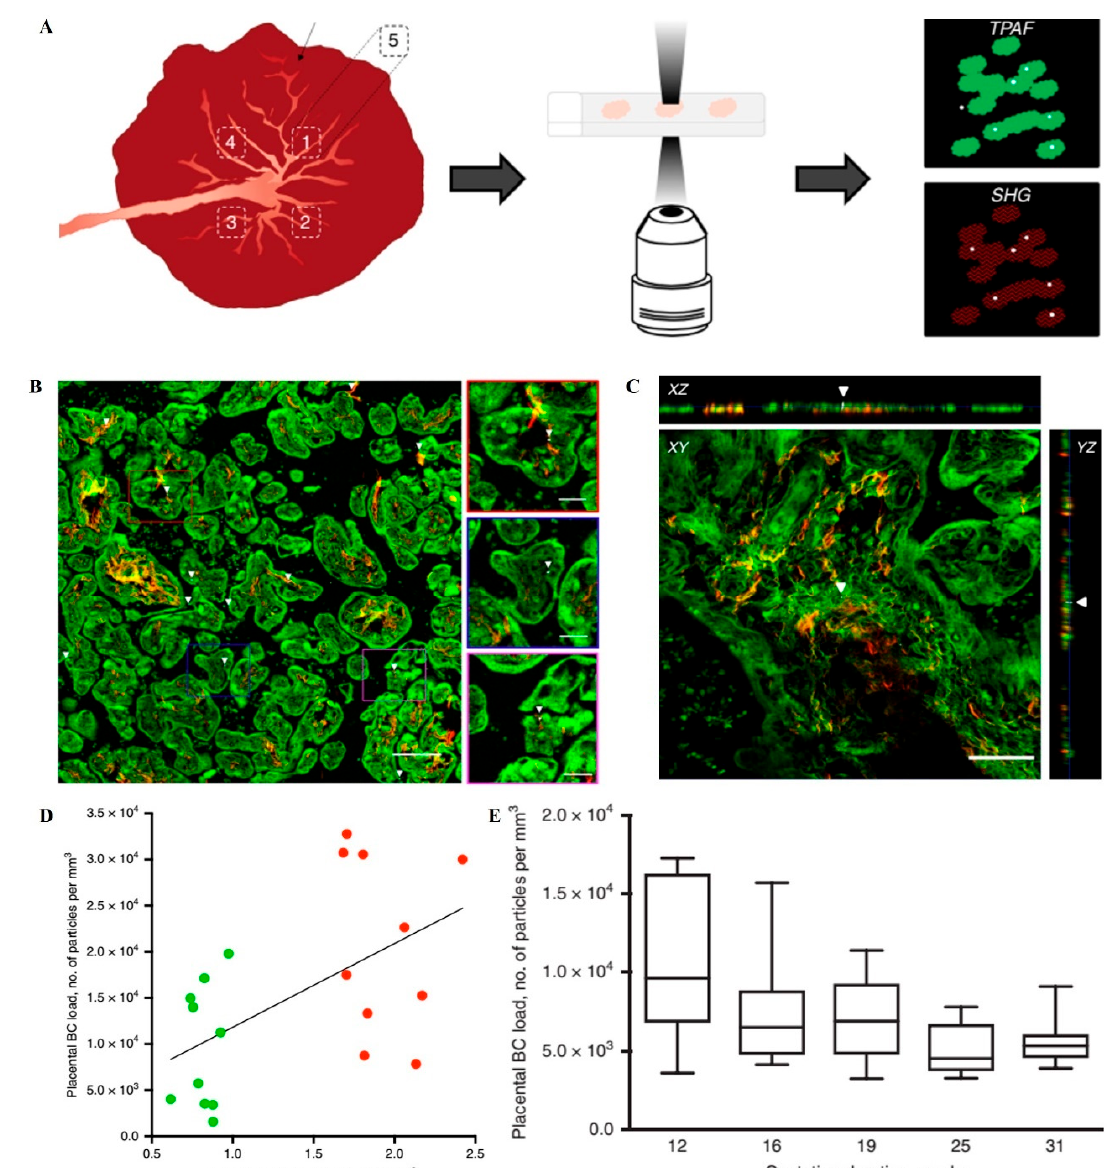
Figure 1. The protocol for black carbon detection in the placenta and evidence of them at the fetal side of human placenta. ( A ) The detection of BC particles in placenta. The white light produced by the BC naturally present in the tissue (white dots) is detected along with the simultaneous generation and detection of two-photon excited autofluorescence (TPAF) of the cells (green) and second harmonic generation (SHG) from collagen (red). ( B ) The evidence of ambient BC particles at the fetal side of human placenta. White light (WL) generation originating from the BC particles (white and further indicated using white arrowheads) under femtosecond pulsed laser illumination (excitation 810 nm, 80 MHz, 10 mW laser power on the sample) is observed. Scale bar: 30 μ m. ( C ) Validation of the carbonaceous nature of the identified particles inside the placenta. XY-images acquired throughout a placental section in the z-direction and corresponding orthogonal XZ-projections and YZ-projections showing a BC particle (white and indicated by white arrowheads) inside the tissue (red and green). Scale bar: 50 μ m. ( D ) Correlation between placental load and residential exposure of CB particles throughout the whole pregnancy. The line is the regression line. Green and red dots indicate low (n =10 mothers) and high (n = 10 mothers) exposed mothers. ( E ) BC load in placentas from spontaneous preterm births (n = 5). The whiskers indicate the minimum and maximum value and the box of the box plot illustrates the upper and lower quartile. The median of spreading is marked by a horizontal line within the box. Reproduced with permission [36]. Copyright Springer Nature , 2019.